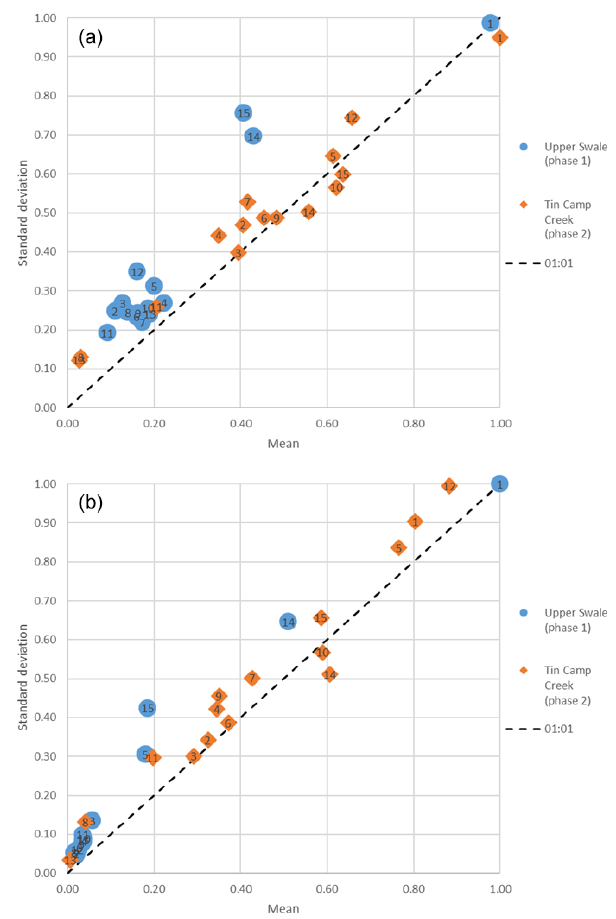
Figure 4. Aggregated scores for sediment yield (a) and internal ge- omorphology (b) where the numbers 1–15 represent the following: 1 is the sediment transport formula (SED); 2 is the maximum erode limit (MEL); 3 is the in channel lateral erosion rate (CLR); 4 is the lateral erosion rate (LAT); 5 is the critical vegetation shear stress (VEG); 6 is the grass maturity rate (MAT); 7 is the soil creep rate (SCR); 8 is the slope failure threshold (SFT); 9 is the in/out dif- ference (IOD); 10 is the minimum Q value (MinQ); 11 is the maxi- mum Q value (MaxQ); 12 is the slope for edge cells (SEC); 13 is the evaporation rate (EVR); 14 is the Manning n roughness coefficient (MNR); and 15 is the grain size set